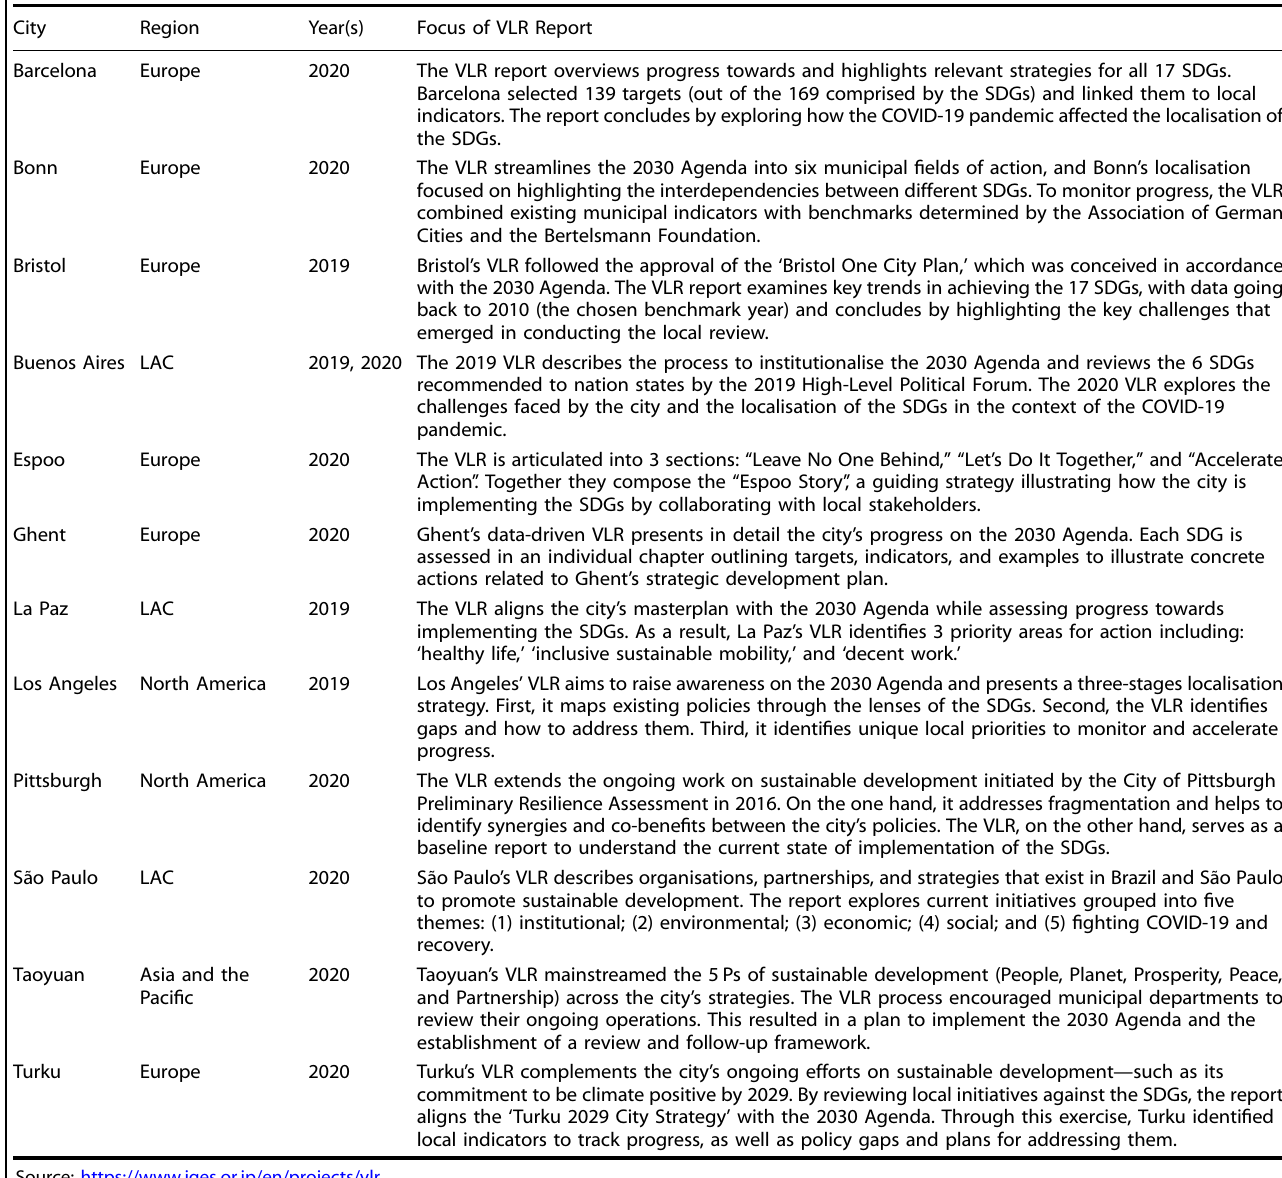
Table 1. Brief overview of the VLRs reports presented by the cities that were part of the